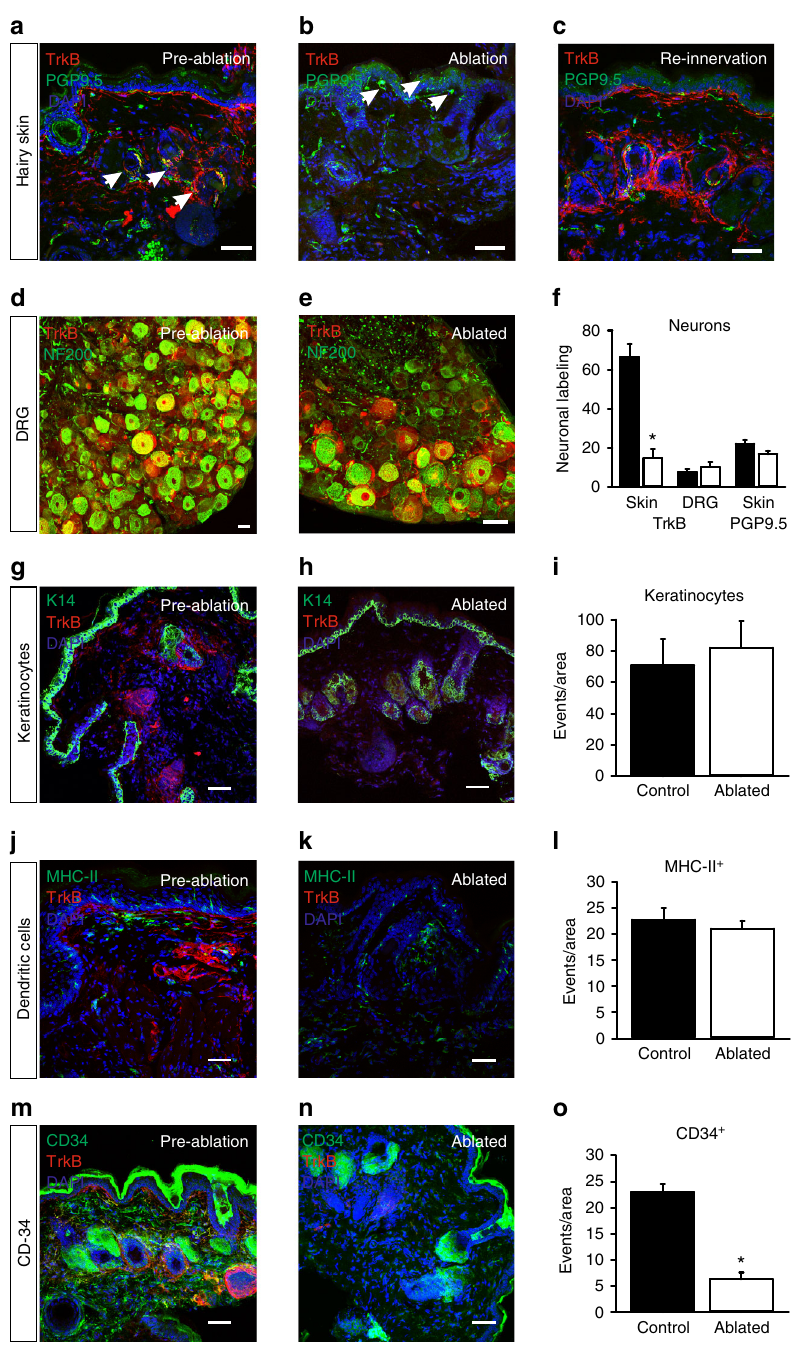
Fig. 6 BDNF SNAP -IR700 photoablation promotes local retraction of TrkB + afferents. a – c Substantial loss of TrkB CreERT2 positive afferents (red), but persistence of other fi bers (green) upon BDNF SNAP -IR700-mediated photoablation. a Innervation of paw hairy skin prior to ablation, arrows show lanceolate endings. b Loss of TrkB CreERT2 afferents after ablation, arrows show PGP9.5 fi bers. c Re-innervation of skin by TrkB CreERT2 afferents at 24 days post ablation. d DRG section from control TrkB CreERT2 mouse labeled for RFP (red) and NF200 (green). e DRG section from photoablated TrkB CreERT2 mouse labeled for RFP (red) and NF200 (green). f Quanti fi cation of the proportion of hair follicle innervation and DRG neurons positive for TrkB following photoablation in the paw and the quanti fi cation of PGP9.5 + free nerve endings showing the numbers of free nerves remain unaffected. Representative skin sections from control and BDNF SNAP -IR700 photoablated mice labeled with the indicated antibodies. TrkB-positive cells are indicated in red and DAPI- positive nuclei in blue. g , h Keratinocytes labeled with K14 (green). i Quanti fi cation of the number of K14 + cells. j , k Dendritic cells and dermal antigen- presenting cells labeled with MHC-II (green) and l the quanti fi cation for MHC-II + cells. m , n Mast cells and epithelial and endothelial progenitor cells labeled with CD34 (green). o Quanti fi cation of the number of K14 + cells. Scale bars, 40 µ m. Error bars indicate